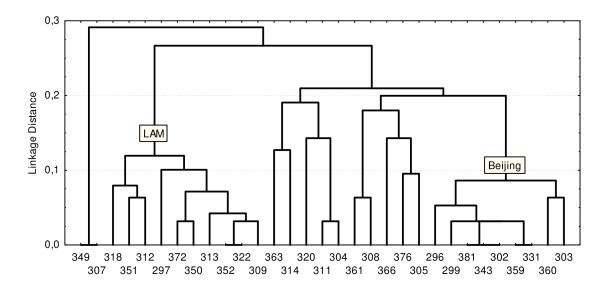
Clustering dendrogram of 31 isolates from M. tuberculosis constructed from results of VNTR-typing. The abscissa axis is number of isolate. The ordinate axis is a linkage distance.